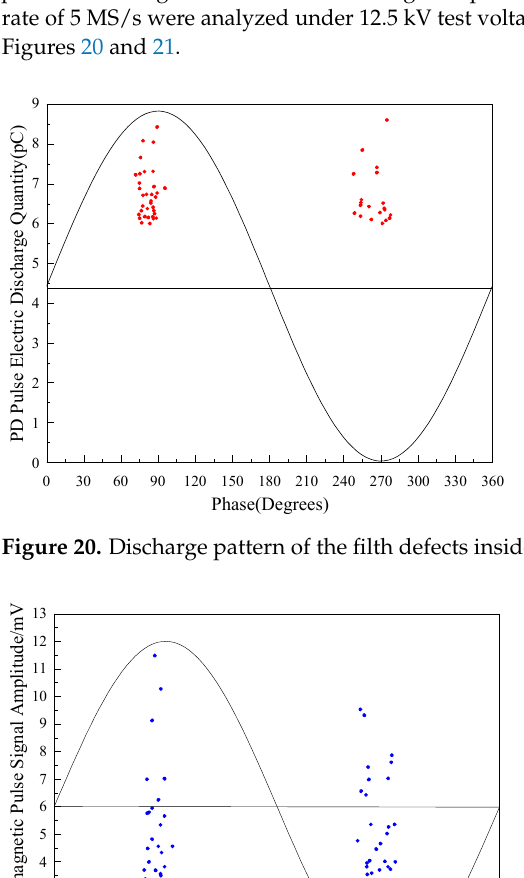
Figure 19. Signal waveform of flexible antenna collected at two voltage levels: ( a ) 12.5 kV and ( b ) 13.6 kV.